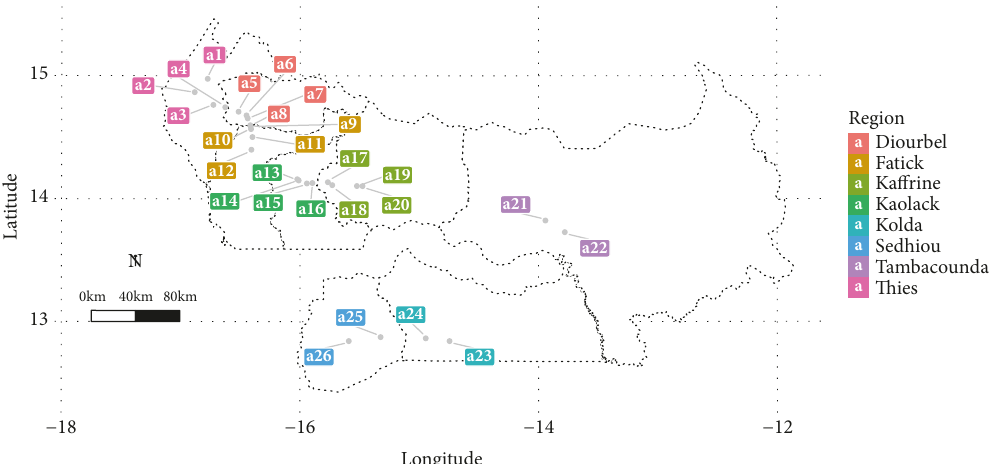
Figure 2: Map showing surveyed fields across the pearl millet productive regions of Senegal during rainy season